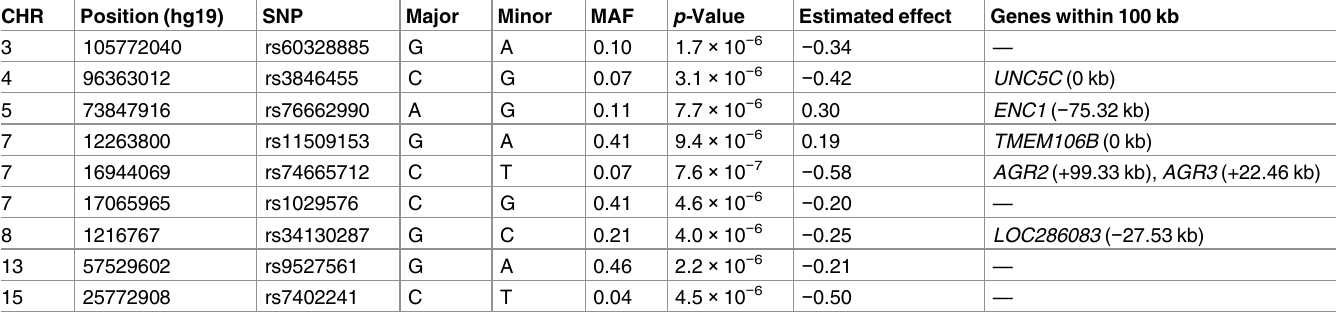
Table 2. Lead SNPs for each independent locus associatedwith residual cognition.